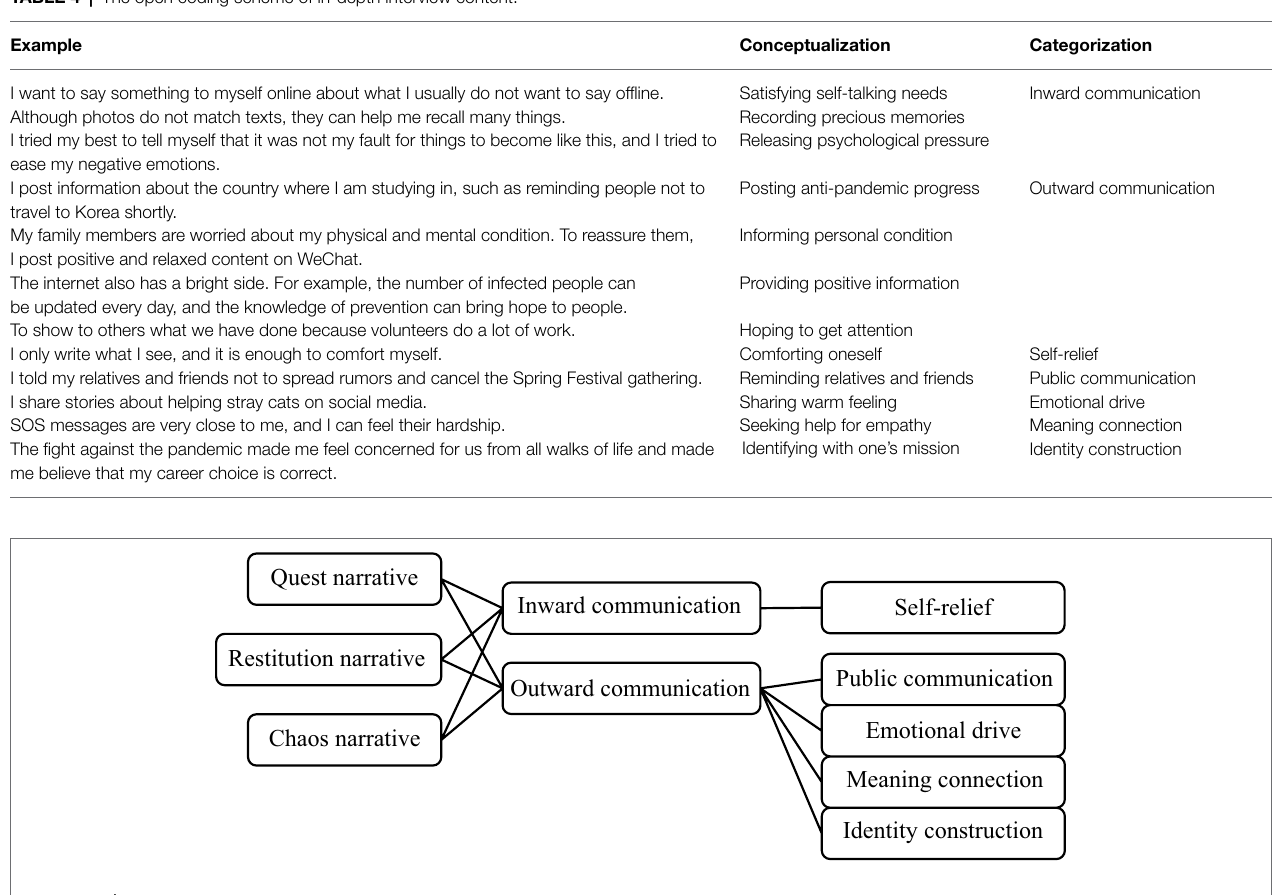
TABLE 4 | The open coding scheme of in-depth interview content.